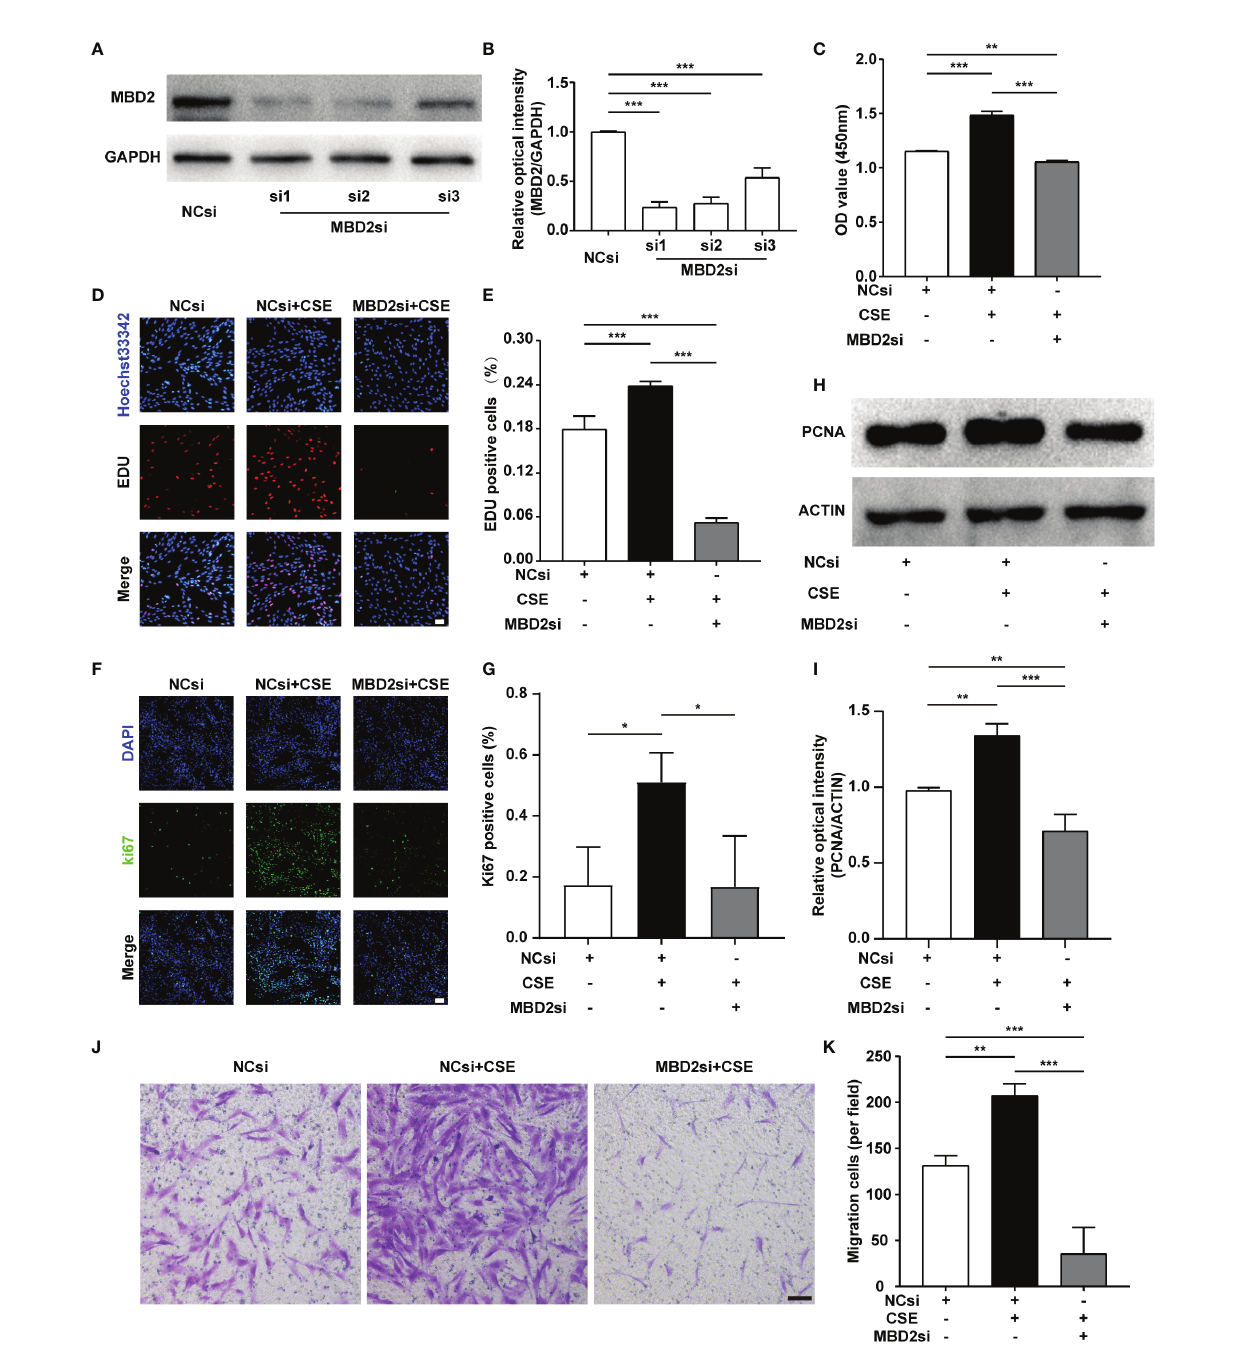
FIGURE 3 | Effect of MBD2si on the changes in proliferation and migration of CSE-induced HPASMCs. (A) MBD2si reduced the MBD2 protein expression in HPASMCs. (B) Quantitative analysis results of graph A based on the density of the bands. (C) CCK8 test was used to assess cell proliferation in HPASMCs transfected with negative control siRNA (NCsi) or MBD2si, stimulated with 2% CSE or control solvent for 24h. The subsequently divided groups were the same. (D) The proliferation of HPASMCs was measured by the EdU proliferation assay. All images are 200× magni fi cation. Scale bar = 50 m m. (E) Quantitation of EdU ‐ positive cells. (F) Ki67 immuno fl uorescence was applied to measure the proliferation of HPASMCs. All images are 200× magni fi cation. Scale bar = 50 m m. (G) Quantitation of Ki67 ‐ positive cells. (H) Representative Western blot images of PCNA in HPASMCs. (I) Quantitation of PCNA bands based on the density. (J) The HPASMCs migration images. All images are 100× magni fi cation. Scale bar = 100 m m. (K) Quantitation of migration cells. The data are presented as mean ± SD, n=3. * P < 0.05, ** P < 0.01, *** P <